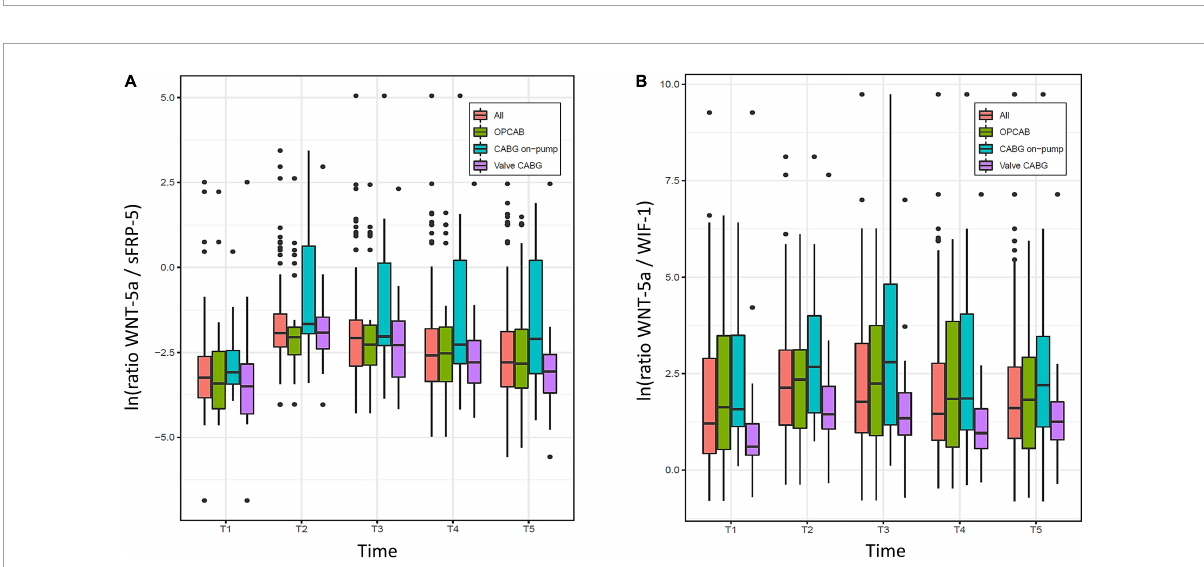
FIGURE4 Evolution of ratios between (A) Wingless-related integration site 5a (WNT-5a) and Secreted frizzled-related protein 5 (sFRP-5), and (B) WNT-5a and WNT inhibitory factor 1 (WIF-1) over time (T1–T5) in the overall population (All) and the three groups (OPCAB, CABG on-pump and valve-CABG). Values are presented as median and interquartile range (IQR) (box), within 1.5 × IQR (line) and outliers (dots). ln, natural logarithm; T1, baseline; T2, time of intensive care unit (ICU) admission; T3, 4 h after surgery; T4, 8 h after surgery; T5, 48 h after surgery; CABG, coronary artery bypass grafting; OPCAB, off-pump coronary artery bypass